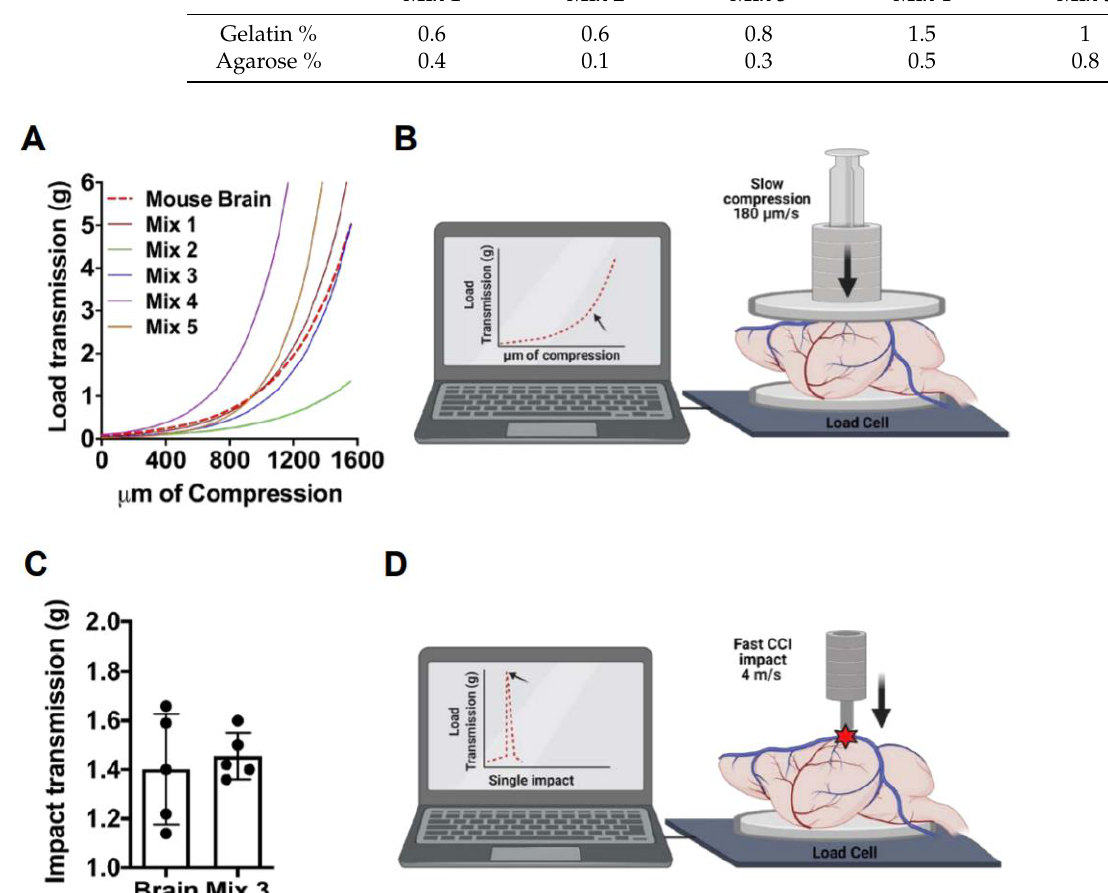
Figure 1. Phantom brain development. Phantom brain and mouse brains were analyzed and compared using slow uniaxial compression assay and fast impact assay. ( A , B ). Visualization of the non-linear curve fit models generated from the different preparations and mouse brains analyzed by a slow ( 180 μm/s) uniaxial compression assay to evaluate stiffness. Non-linear fit test of Phantom brain Mix 3 resulted in a shared curve model equation Y = 0.06650 *exp(0.002669*X), r 2 0.9680; p = 0.9651; n = 3. ( C , D ). Impact transmission of CCI at 4 m/s, performed in the mouse brain, and compared to the phantom brain (Mix 3) n = 5. Phantom brain (1.456 g ± 0.09) and mouse brain (1.402 g ± 0.22) displayed a similar response to CCI (Student t -test; p = 0.6453).